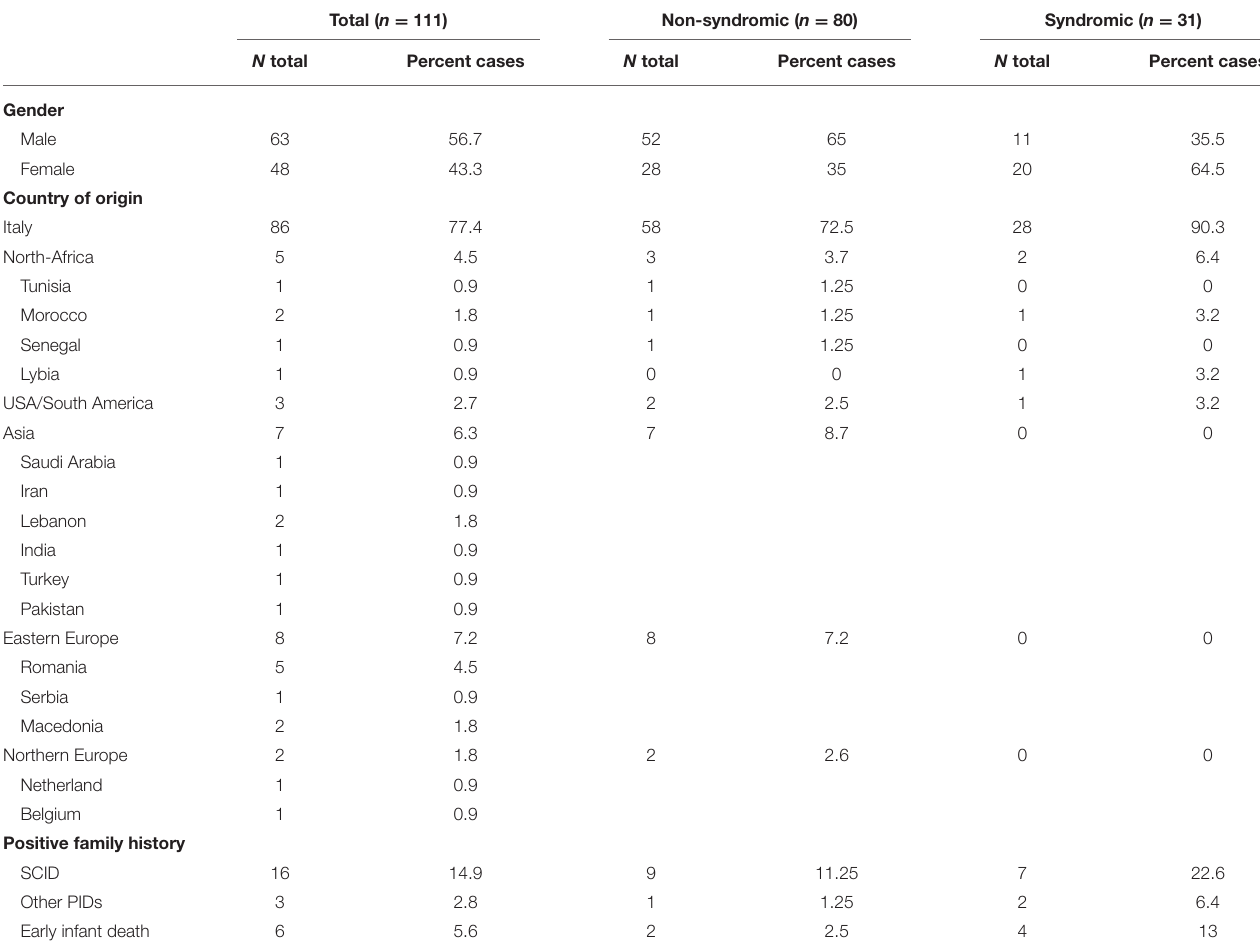
TABLE 1 | Demographic features of the SCID